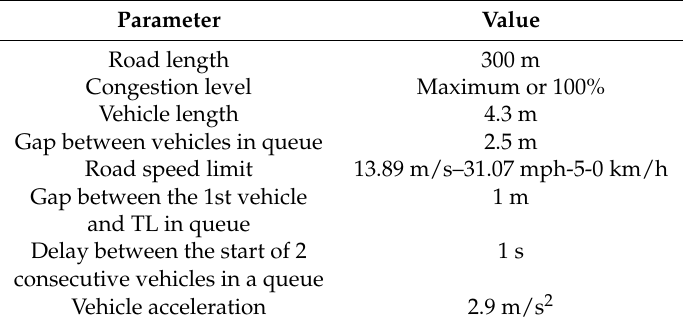
Table 1. Vehicles and road network parameters.